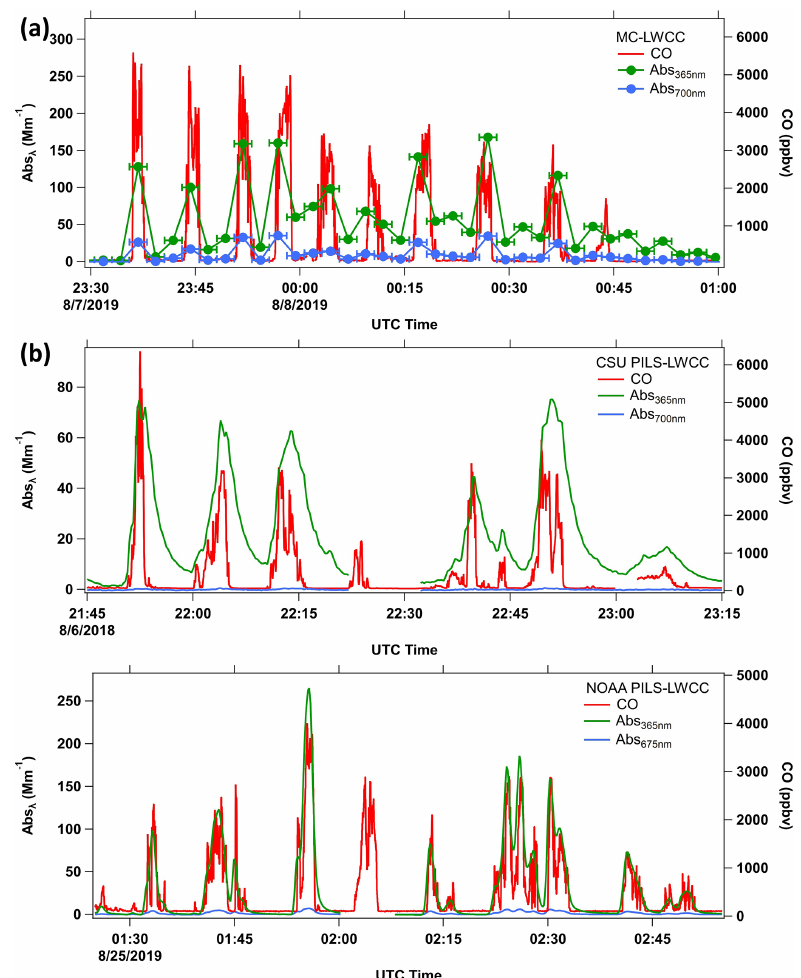
Figure 4. Example data from sampling in smoke plumes by MC-LWCC and PILS-LWCC (CSU and NOAA) systems for the flights shown in Fig. 3. Time series of Abs 365nm (green), Abs 700nm or Abs 675nm (blue) and CO (red) for the (a) FIREX-AQ NASA DC-8 flight on 7 August 2019, (b) WE-CAN NSF C-130 flight on 6 August 2018 and (c) FIREX-AQ NOAA Twin Otter flight on 24 August 2019. The sampling frequencies were (a) MC-LWCC, 2.5min; (b) CSU PILS-LWCC, 16s; (c) NOAA PILS-LWCC, 10s; and CO, 1s. Horizontal error bars in (a) represent the MC sampling